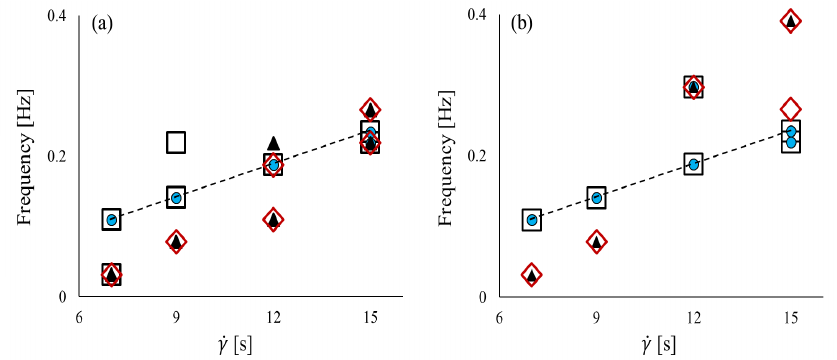
Figure 11: Dominant frequencies for α (open black squares), ˙ 𝛾 h (closed blue circles), ˙ 𝛾 l (closed black triangles) and ˙ 𝛾 true (open red dia- monds) for (a) protocol 1 (no pre-shear) and (b) protocol 2 (with pre-shear). Dashed lines correspond to the rotationally correlated frequen- cies.